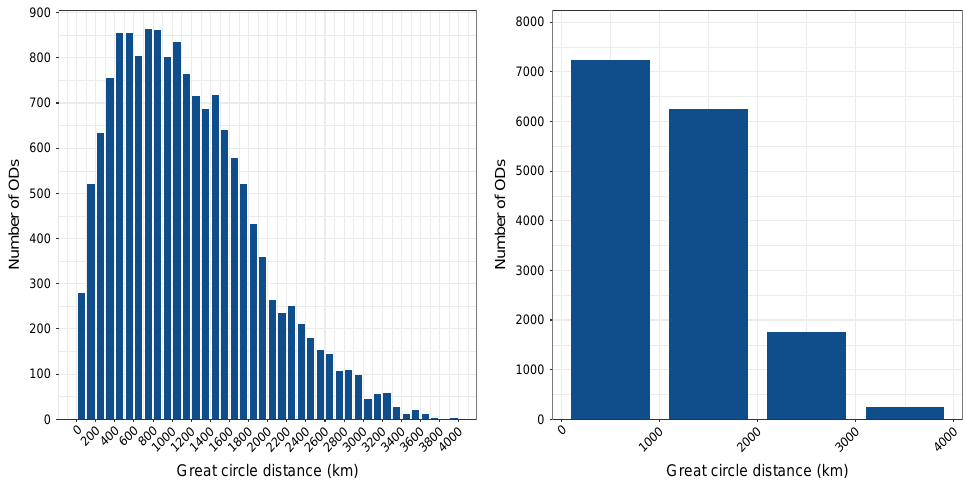
Figure 2. Distribution of the number of OD pairs across a great circle distance between